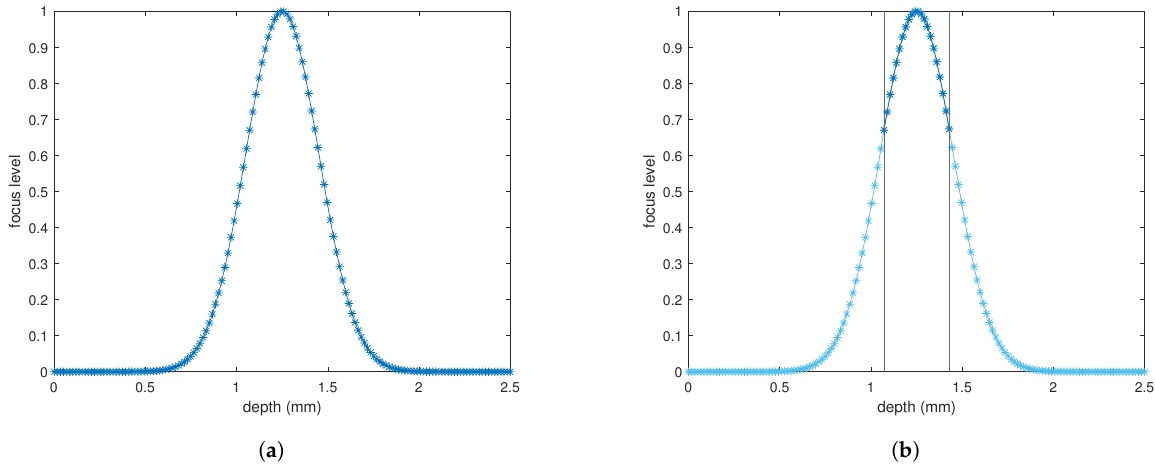
Figure 1. ( a ) Representation of a normalized pixel focus level Gaussian distribution when varying the focus point through the focal plain of a pixel. 0 equals fully out of focus, 1 equals maximum focus. Every point represents a captured image. ( b ) Thresholded profile, with sufficient points to determine pixel